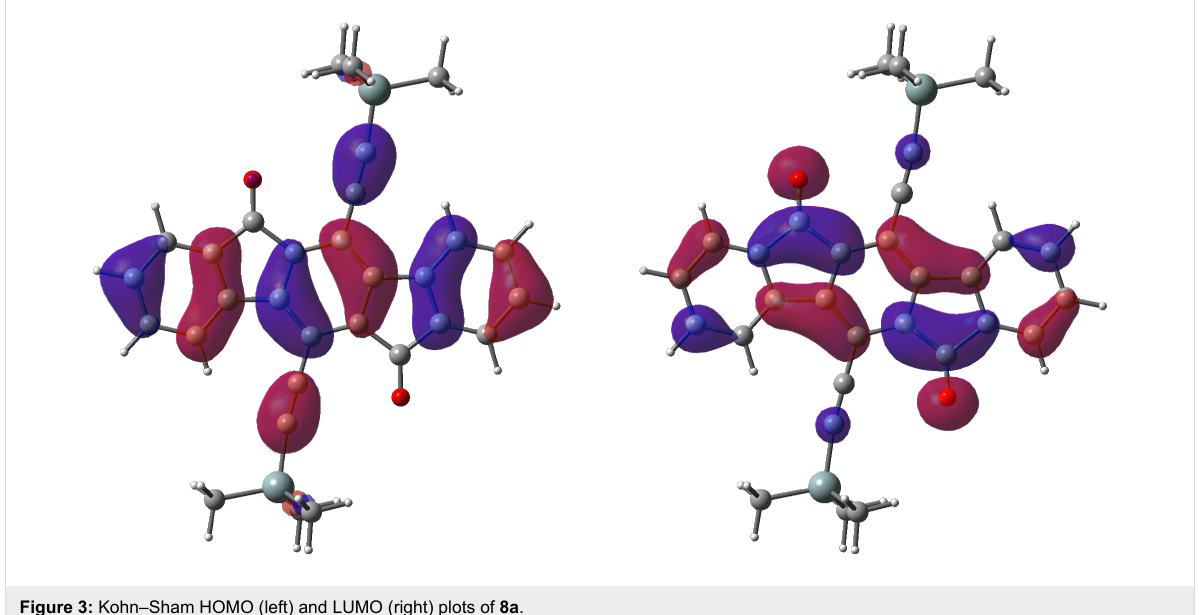
Figure 3: Kohn–Sham HOMO (left) and LUMO (right) plots of 8a .